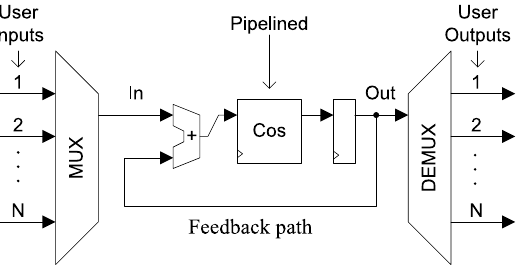
Figure 12. Block diagram of synthetic cosine application with added feedback.